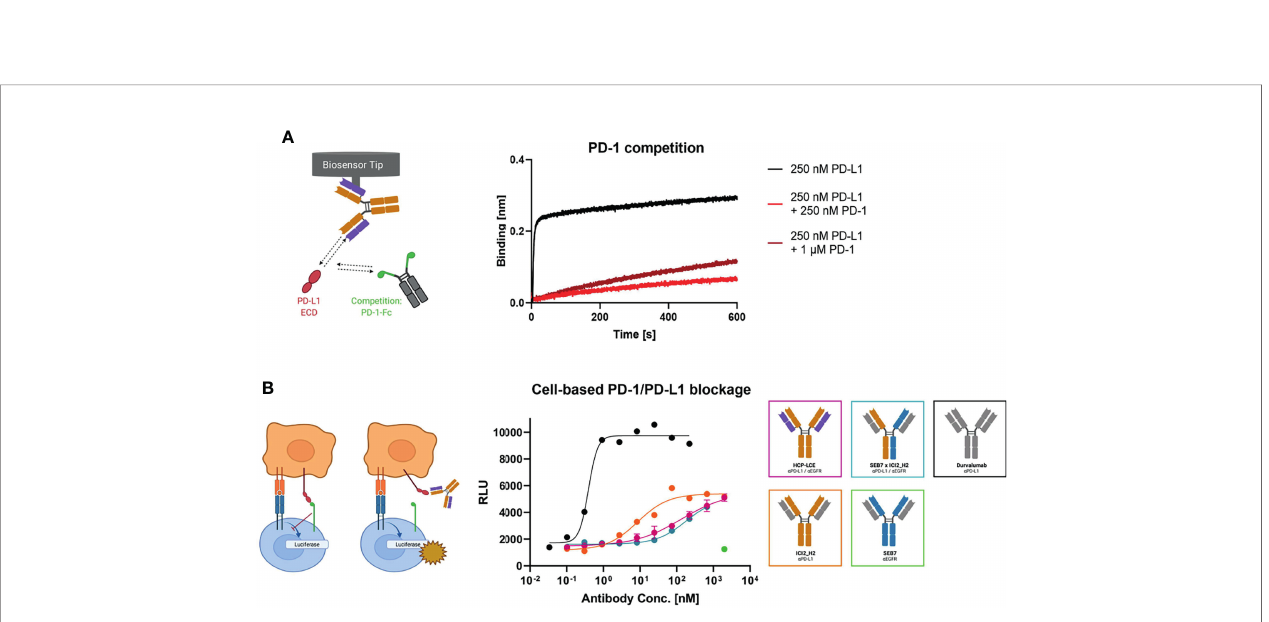
FIGURE 5 | PD-1 competition and PD-1/PD-L1 blockage assays. (A) BLI-assisted PD-1 competition assay. HCP-LCE was loaded onto FAB2G biosensors and subsequently associated to PD-L1 pre ‐ incubated with varying PD-1 concentrations. The binding of HCP-LCE to PD-L1 at different PD ‐ 1 concentrations reveals dose-dependent binding. (B) Cell-based PD-1/PD-L1 blockage assay. SEB7 (green), ICI2_H2 (orange), the bispeci fi c construct SEB7xICI2_H2 (blue) and durvalumab (black) were tested in comparison to the Two-in-One antibody HCP-LCE (pink). EC 50 values: durvalumab, 0.39 nM; ICI2_H2, 8.60 nM; SEB7xICI2_H2, 179 nM; HCP-LCE, 214 nM. Luciferase activity is plotted against the logarithmic antibody concentration. All measurements were performed in duplicates, and the experiments were repeated at least three times, yielding similar results. Created with